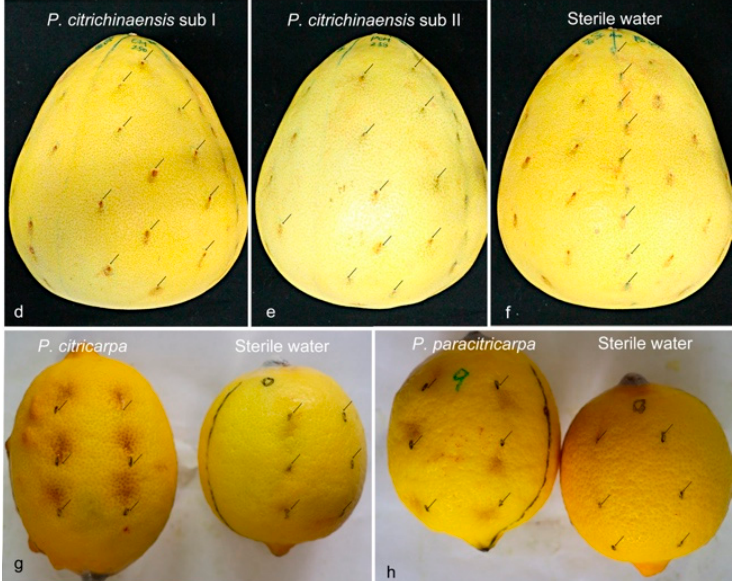
Figure 7. Pathogenicity assay of P. capitalensis , P. citriasiana subclade I and subclade II, P. citrichinaensis subclade I and subclade II on fruits of C. maxima cv. Guanximiyou, P. citricarpa and P. paracitricarpa on fruits of C. limon ; ( a – f ) C. maxima cv. Guanximiyou fruits inoculated with P. capitalensis , P. citriasiana subclade I and subclade II, P. citrichinaensis subclade I and subclade II, and sterile water, ( g , h ) C. limon fruits inoculated P. citricarpa (fruit on the left), P. paracitricarpa (fruit on the left) and sterile water (fruit on the right). Black arrows indicate the injected positions.